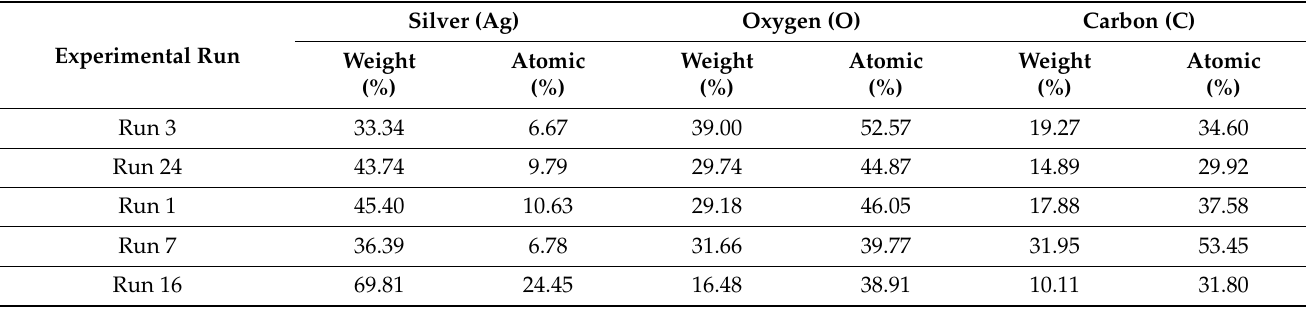
Table 5. Elemental analysis of prepared AgNPs (run 3, run 24, run 1, run 7 and run 16) using five spectrums focused at three distinct